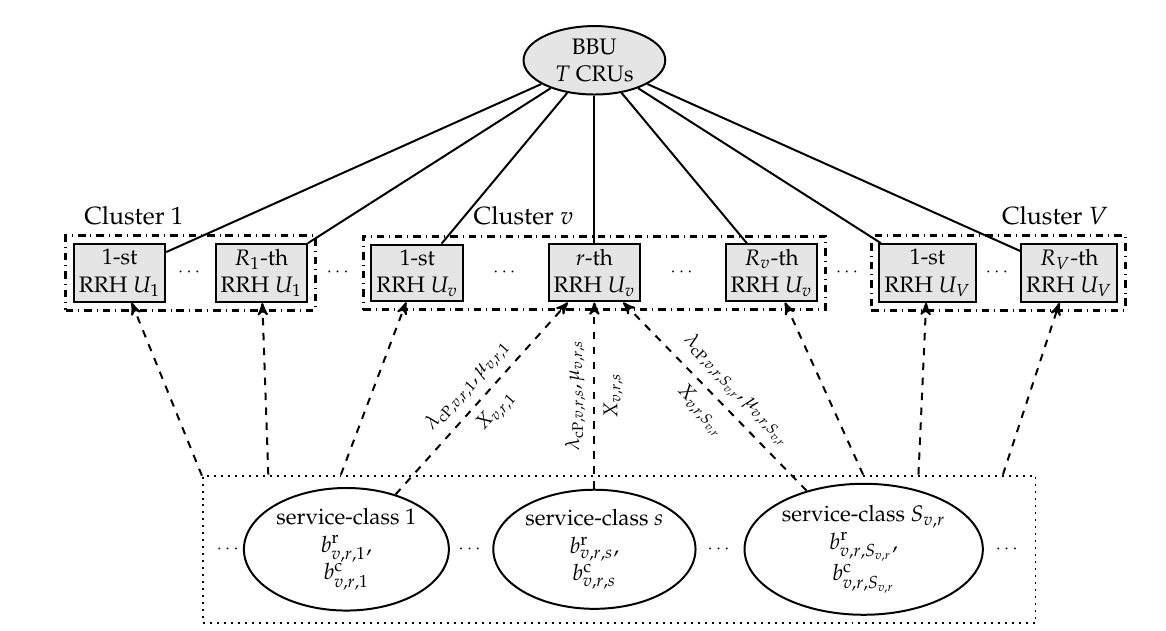
Figure 10. The extended proposed c-MC-MC